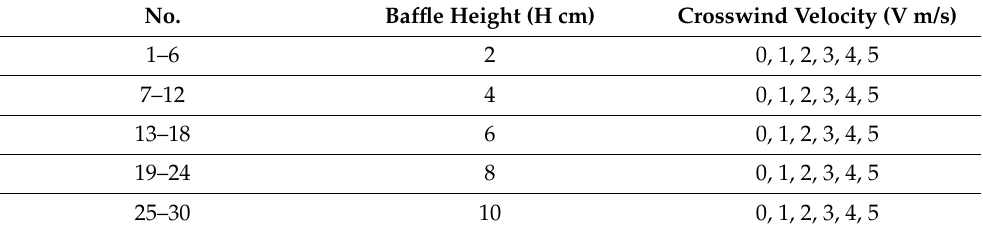
Table 1. A summary of the experimental and simulation scenarios.